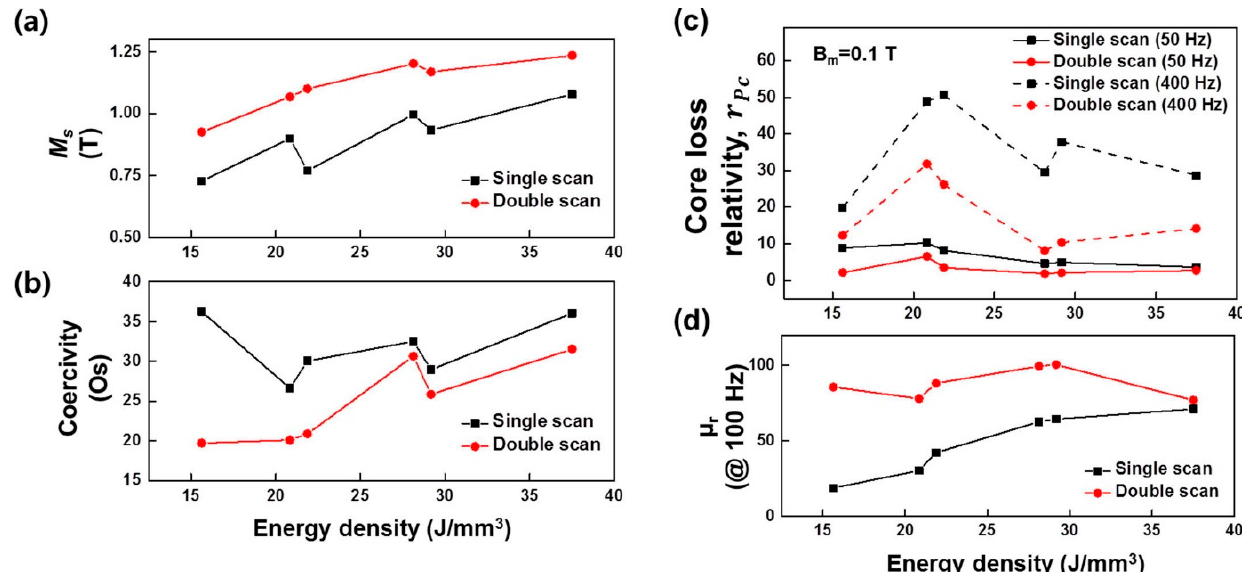
Figure 12. The graph of ( a ) macroscopic photograph of 3D-printed Fe 73.7 Si 11 B 11 C 2 Cr 2.28 alloys, ( b ) relative density and ( c ) transverse rupture strength (TRS) versus laser energy density and ( d ) optic microscope images of double-scanned alloys (reprinted with the permission from [75], Elsevier, 2020).